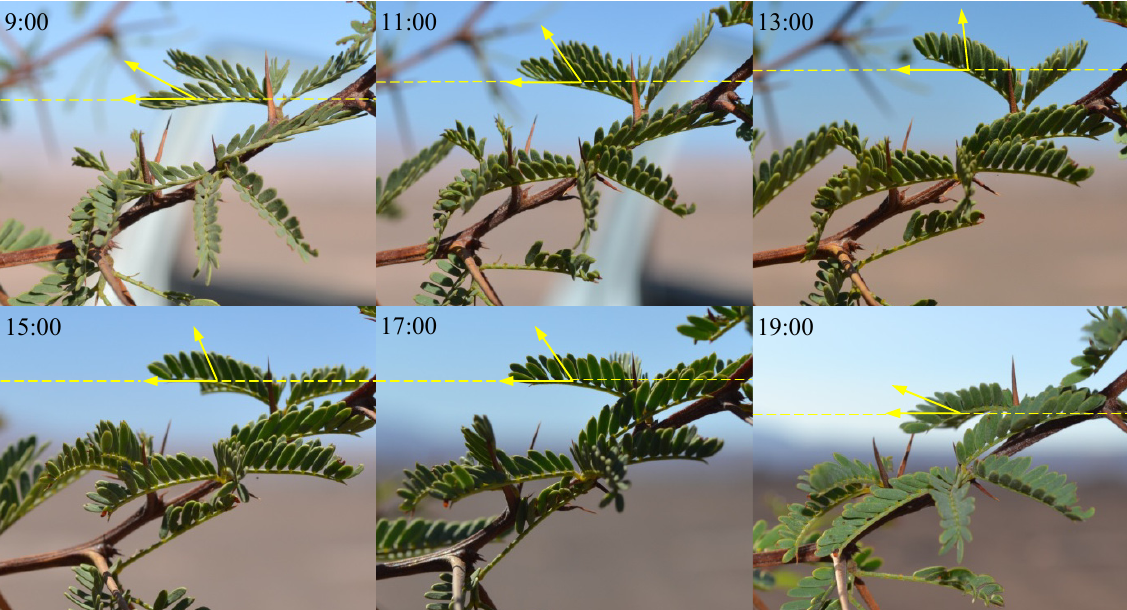
Figure 11. Pulvinar movement of Tamarugo leaves recorded on 13 January 2012.